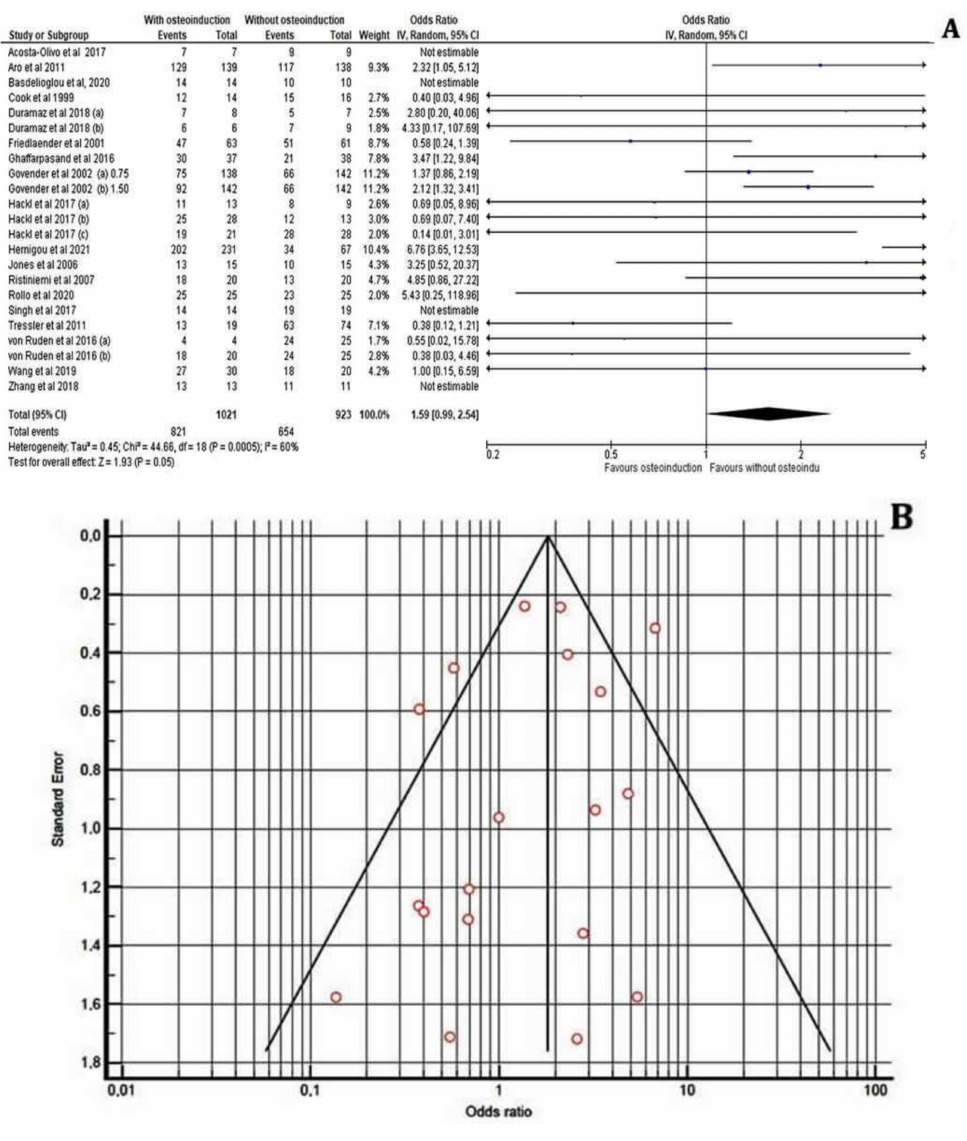
Figure 3. ( A ) Forest plots showing the overall likelihood of sufficient bone healing after the application or not of osteoinductive factors in fracture site. ( B ) Funnel plot of the Egger’s test utilised to evaluate the publication bias